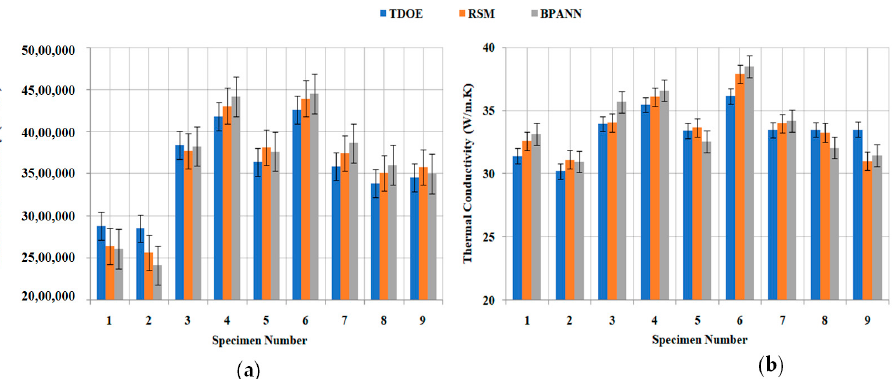
Figure 17. Experimental versus RSM versus BPANN prediction values of ( a ) electrical conductivity and ( b ) thermal conductivity. Table 14. Electrical conductivity and thermal conductivity of Ti-6Al-4V-SiC(15 Wt.%) specimen processed under various processing conditions.